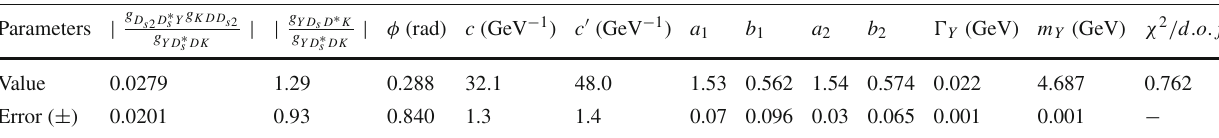
Table 1 The parameters for fitting the experimental line shape on the recoil mass spectra of K + of e + e − → D ∗− s D 0 K + + D − s D ∗ 0 K +